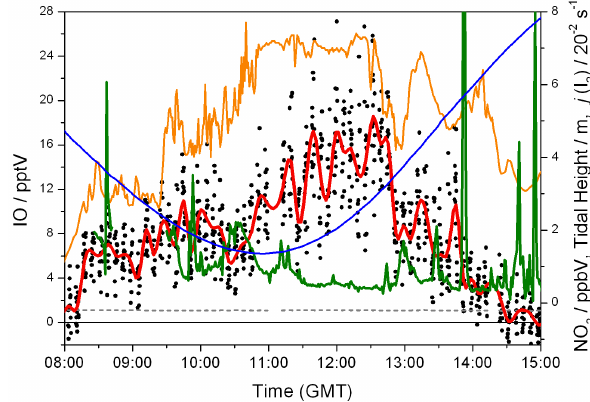
Fig.9. TheIOprofileon7thSeptember. AnNO 2 spike(greenline)around10:30correspondstoasignificantdecreaseinIOconcentrations (blackcircles=10sintegrationperiod, redline=150sintegrationperiod). AlsoshownistheLIFdetectionlimit(10sintegrationperiod, Fig. 9. The IO profile on 7 September. An NO 2 spike (green line) dashedgreyline),tidalheight(blueline)and j (I 2 )(orangeline). around 10:30 corresponds to a significant decrease in IO concentra- tions (black circles=10 s integration period, red line=150 s integra- tion period). Also shown is the LIF detection limit (10 s integration period, dashed grey line), tidal height (blue line) and j (I 2 ) (orange